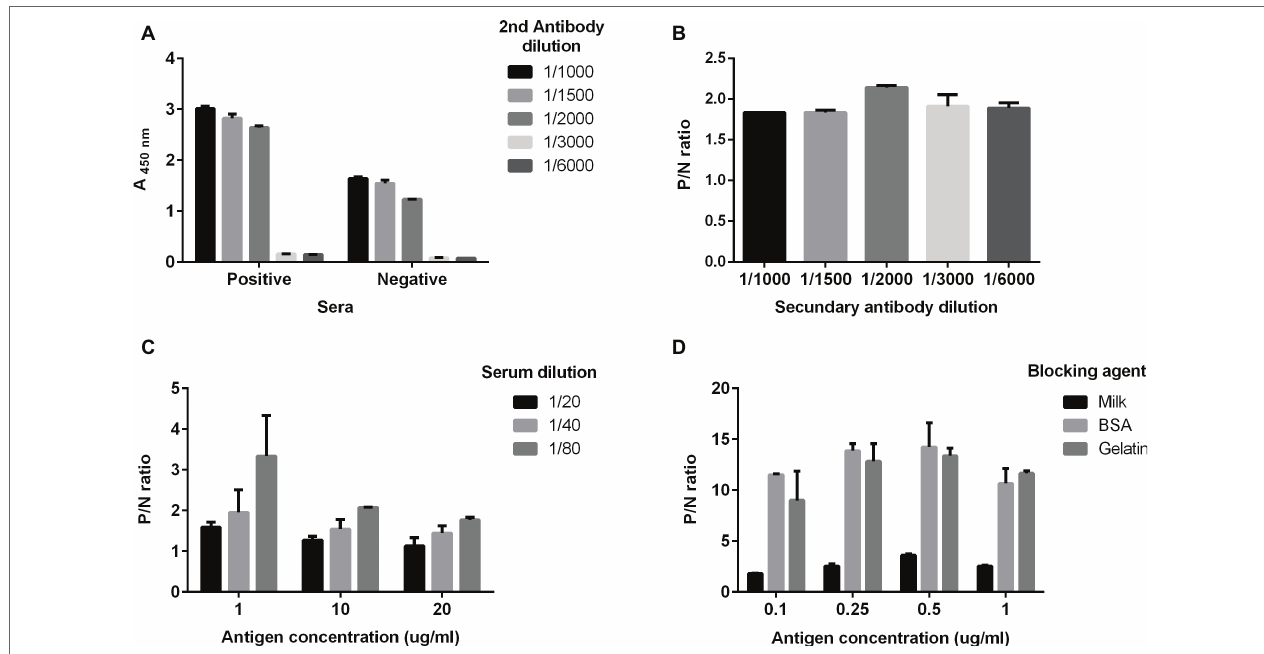
FIGURE 1 | Optimal conditions for the in-house ELISA. Serum samples previously determined as positive or negative for anti-HEV IgG with the commercial kit (DIA. PRO) were used. The optimal dilutions of serum samples (A) and of the secondary antibody were determined (B) using an antigen concentration of 10 μ g/ml. Serum samples positive for anti-HEV IgG or negative for anti-HEV IgG, as previously determined with the commercial assay, were used. (C) Optimal antigen concentration at three serum dilutions 1:20 (black balks), 1:40 (light gray balks) and 1:80 (dark gray balks) and (D) different blocking agents. P/N ratio in (B–D) is calculated as the relation A ( λ 450 nm) positive sample/A ( λ 450 nm) negative control.